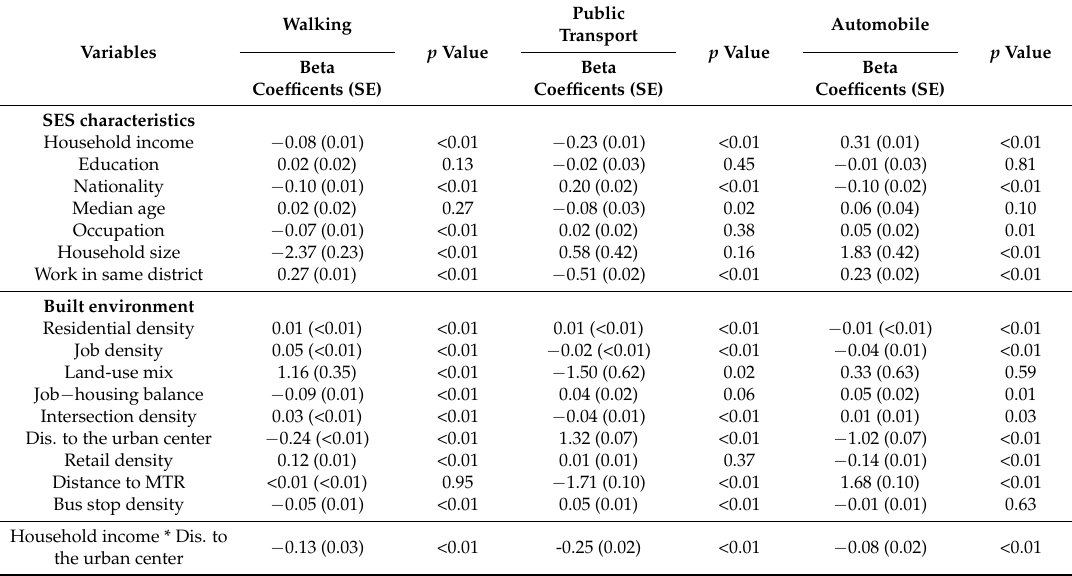
Table 3. Multi-level modeling (generalized linear mixed models) of commuting mode